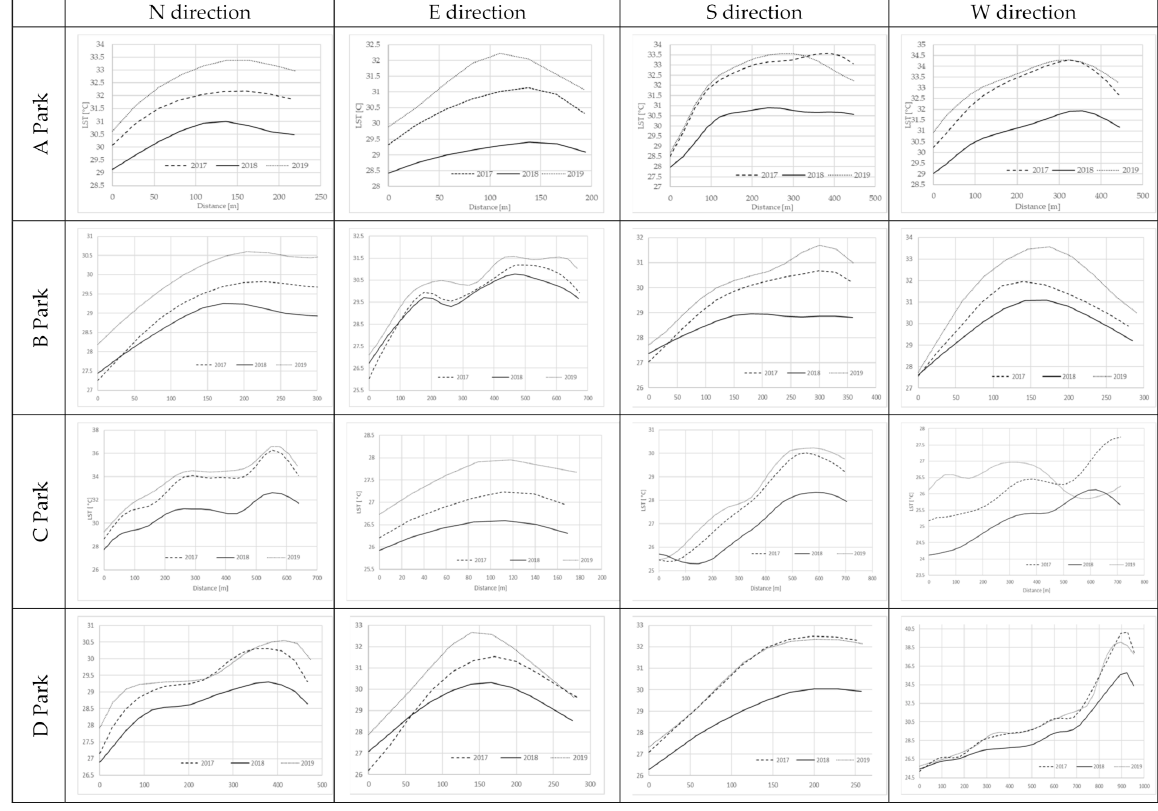
Figure 6. Graphs of LST measured from park boundary to edge of the cooling